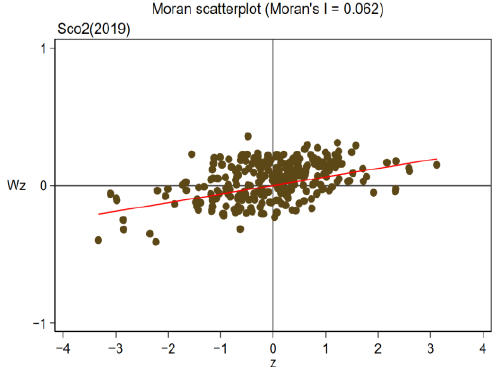
Figure 12. Moran Scatterplot (2019).